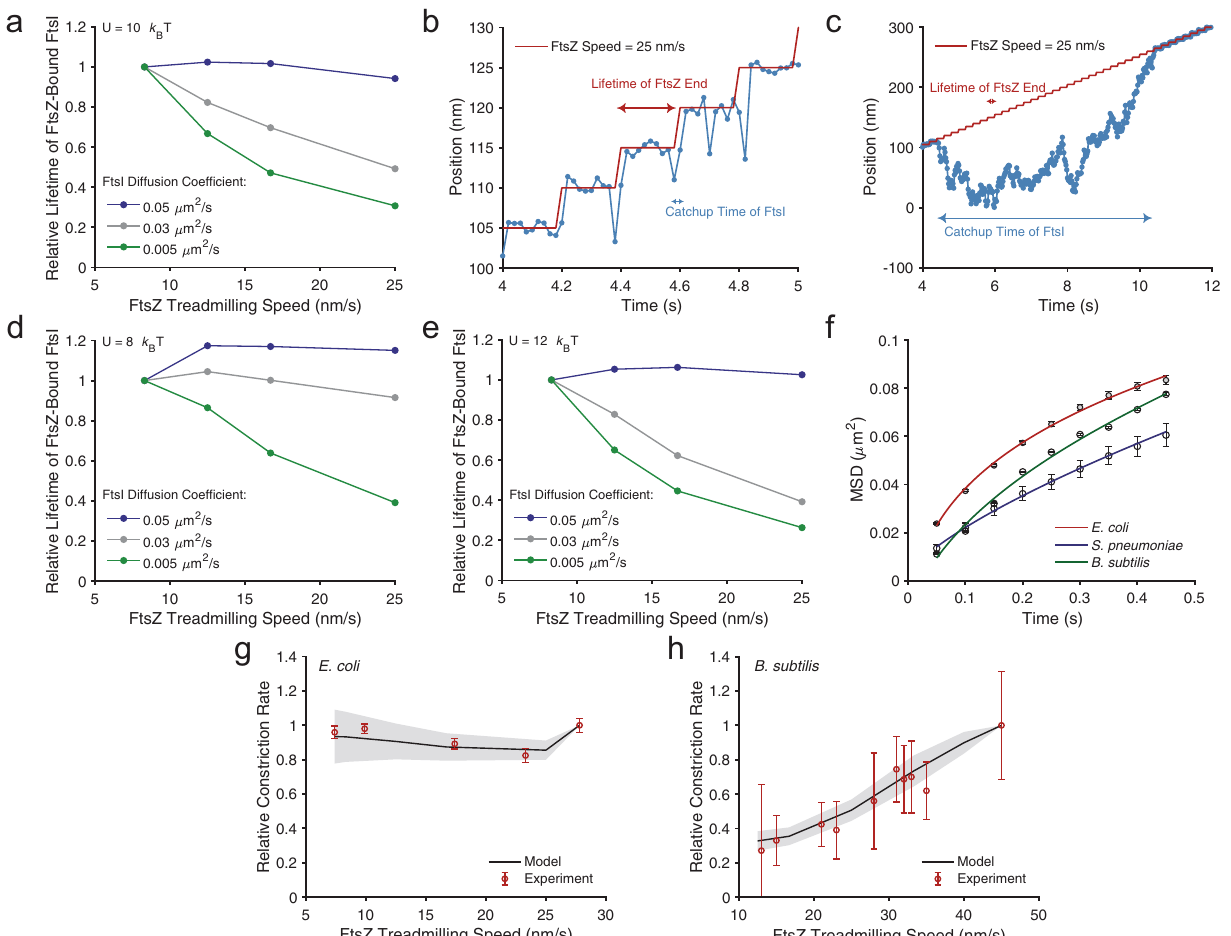
Fig. 5 Diffusion and binding potential modulate sPG synthase ’ s processivity on FtsZ ’ s treadmilling speed. a Predicted dependence of FtsZ-bound FtsI lifetime on FtsZ treadmilling speed with a binding potential of 10 k B T at different FtsI diffusion coef fi cients. b A representative trajectory of persistent end- tracking when FtsI diffusion is fast (0.05 μ m 2 /s). c A representative trajectory of persistent end-tracking when FtsI diffusion is slow (0.005 μ m 2 /s). d Similar to a , but with a weaker binding potential (8 k B T) at different FtsI diffusion coef fi cients. e Similar to a , but with a stronger binding potential (12 k B T) at different FtsI diffusion coef fi cients. For a , d , and e , FtsI is initially randomly positioned along an FtsZ fi lament. The lifetime of FtsZ-bound FtsI was de fi ned as the fi rst time that FtsI escapes from either end of the FtsZ fi lament for greater than 100 nm. For b and c , the model results are plotted every 2 × 10 − 2 s with a simulation time step of 10 − 5 s. f Mean-squared displacement (MSD) of FtsI, PBP2b and FtsW outside the septum in wildtype E. coli , B. subtilis , and S. pneumoniae . The fi tted diffusion constants of FtsI, PBP2b, and FtsW were 0.041, 0.038, and 0.028 µ m 2 /s, with α = 0.29, 0.51, and 0.71, respectively. Error bars represent standard error of the mean. g Model fi tting of the dependence of sPG synthesis activity on FtsZ treadmilling speed in E. coli . The relative experimental data of sPG synthesis activity was taken from previous constriction rate measurements in Coltharp et al. 42 and Yang et al. 13 (mean ± S.E.M., each paper reported at least n > 30 cells). h Model fi tting of the dependence of sPG synthesis activity on FtsZ treadmilling speed in B. subtilis . The relative experimental data of sPG synthesis activity was taken from previous cell division time measurements in Bisson-Filho et al. 12 (mean ± standard deviation. n = 100 cells for cell constriction measurements, n > 50 cells for treadmilling measurements). For g and h , the model fi tting used the measured diffusion constants from f , with varying binding potentials determined by lower and upper limits ( E. coli : 8 and 9 k B T; B. subtilis : 10 and 12 k B T), marking the boundaries of the shaded coef fi cient of FtsW was at 0.028 ± 0.0004 µm 2 /s (mean ± S.E.M., N = 21 trajectories), in the same order of magnitude as that of E.